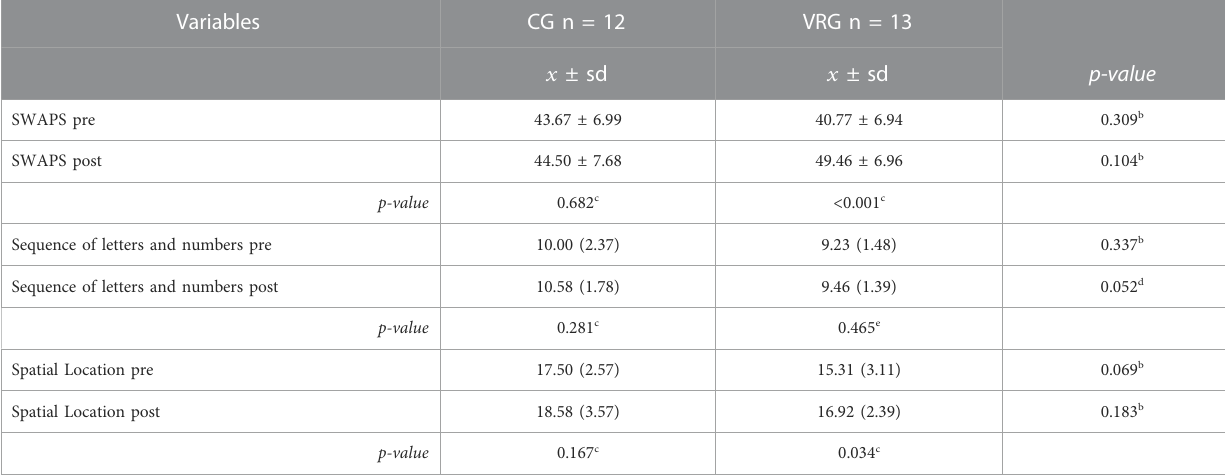
TABLE 3 Comparison of processing speed values in the two groups.